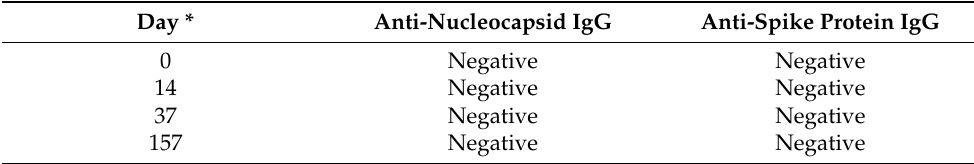
Table 2. Overview of SARS-CoV-2 antibody testing